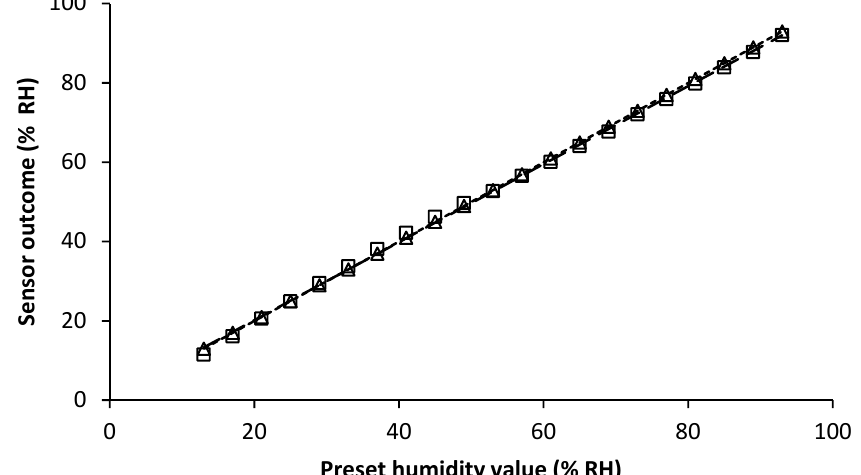
Figure 2. Performance of the humidity component (RH) of the HTU21D sensor. The square shape ( □ ) indicates the measurements associated with increments in RH while the triangle shape ( △ ) indicates measurements associated with decrement changes. The dashed line is the fitting curve for the increment data and the dotted line is the fitting curve based on the decrement data. The fitting equation for the increment test is y = 0.984x + 0.5124 while for the decrement test it is y = 1.0111x + 0.4142.